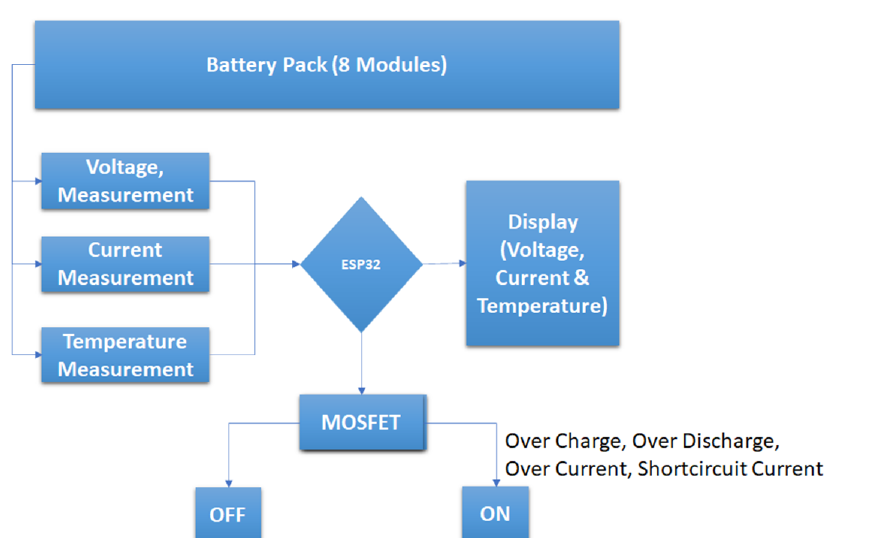
Figure 2. Block diagram of the proposed methodology.